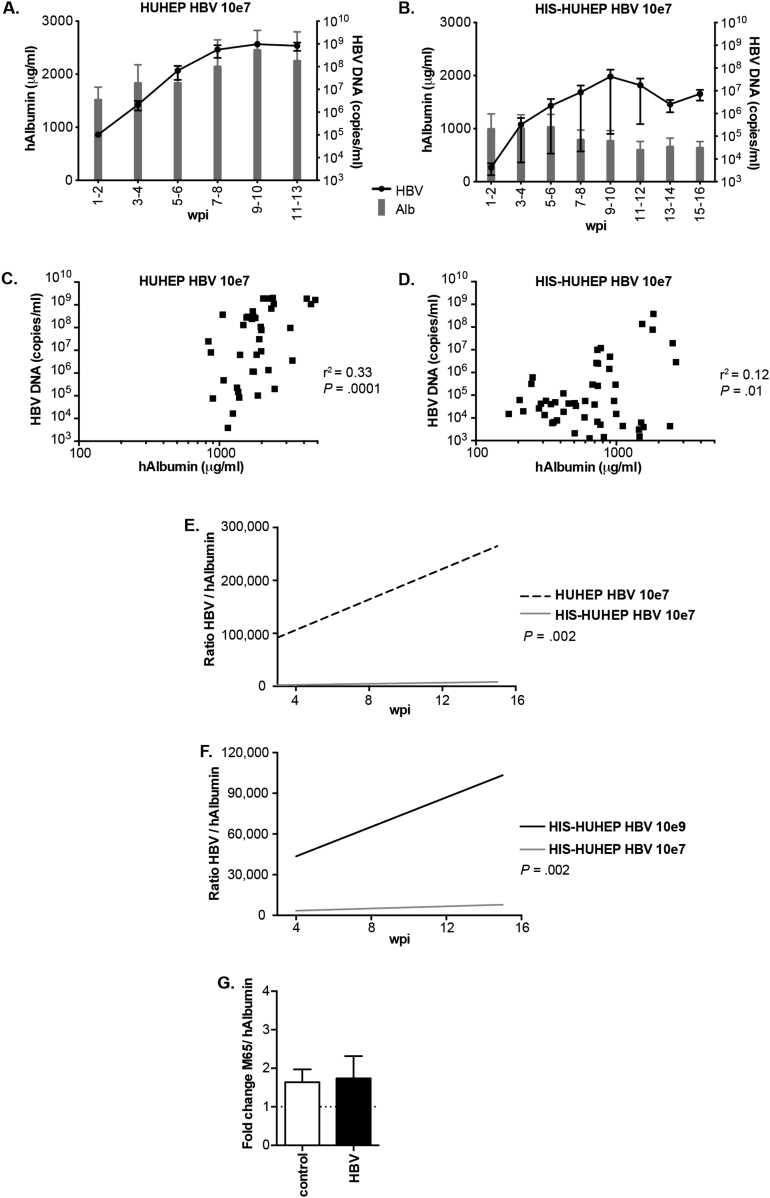
Follow-up of viral loads and liver chimerism in HIS-HUHEP mice inoculated at low-dose HBV 10e7. (A and B) HBV viremia (black line) and hAlbumin (grey bars) were measured longitudinally in the plasma of HBV-infected HUHEP (A) and HIS-HUHEP (B) mice. Graphs show the mean from 6 HUHEP and 6 HIS-HUHEP mice. (C and D) Correlative analysis of the viral load vs liver humanization: for each plasma sample viremia was plotted against hAlbumin concentration from HUHEP (C) (n=6) or HIS-HUHEP mice (D) (n=6). Correlation was evaluated using a 2-tailed Pearson's χ2 test. (E and F) Analysis of viral progression over time: linear regression analysis of the ratio of HBV viral load over hAlbumin concentration plotted against time post infection, from (E) HUHEP (dotted line) or HIS-HUHEP mice inoculated at 10e7 or (F) from HIS-HUHEP mice inoculated at 10e7 vs 10e9 (respectively, grey or black filled line). The P value determines whether the slopes are significantly different. (G) Fold change of M65/hAlbumin pre- and post-infection (17 ±6 wpi) in HUHEP mice (control n=4 HBV 10e7; and 10e9 n=6).